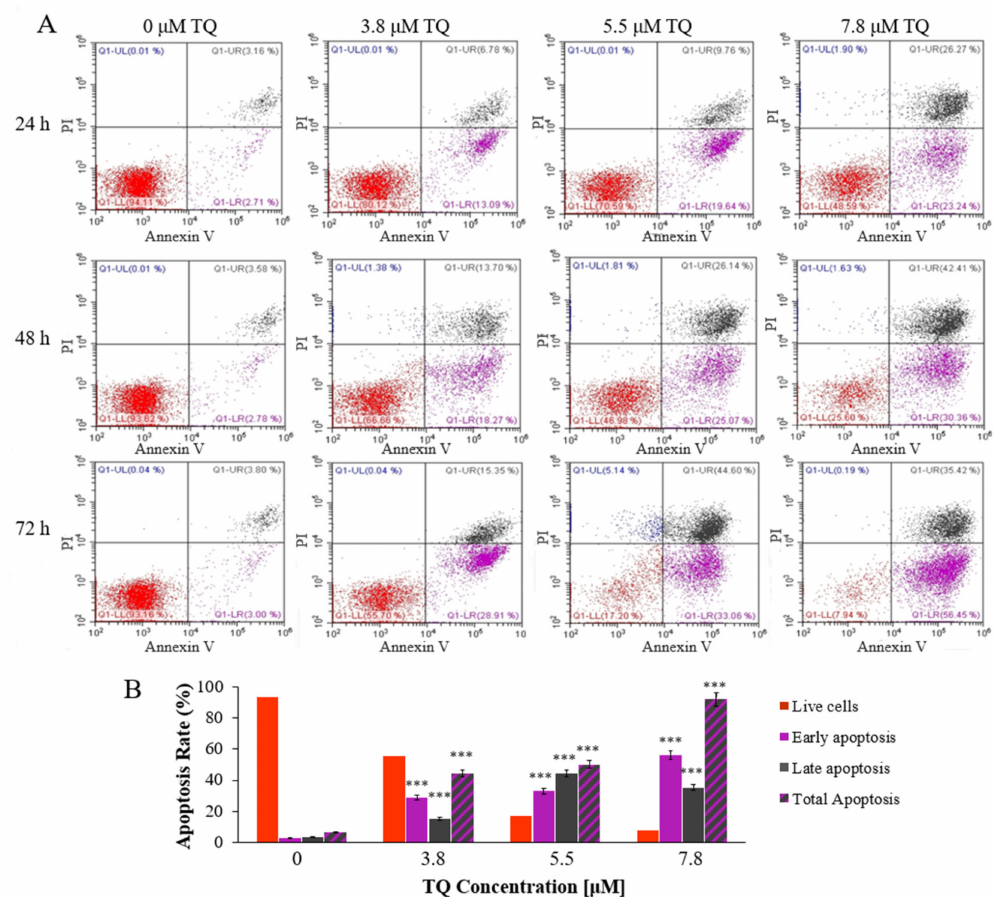
Figure 2. Dose- and time-course effects of TQ on apoptosis in MV4-11 cells. ( A ) Cells were treated with 7.8 µ M, 5.5 µ M, and 3.8 µ M of TQ at 24 h, 48 h, and 72 h. The annexin V-FITC and PI-stained MV4-11 cells were assessed for apoptosis by flow cytometry. ( B ) The graph indicates the apoptosis rate in MV4-11 cells after 72 h of exposure to IC 50 values. The number of total apoptotic cells is presented as a percentage relative to the total cell numbers. The mean apoptosis before and after treatment and between the four groups showed significant difference when tested with repeated measures ANOVA. Data are representative of three independent experiments and expressed as means ± SD. Where *** p < 0.001 is significant versus untreated control